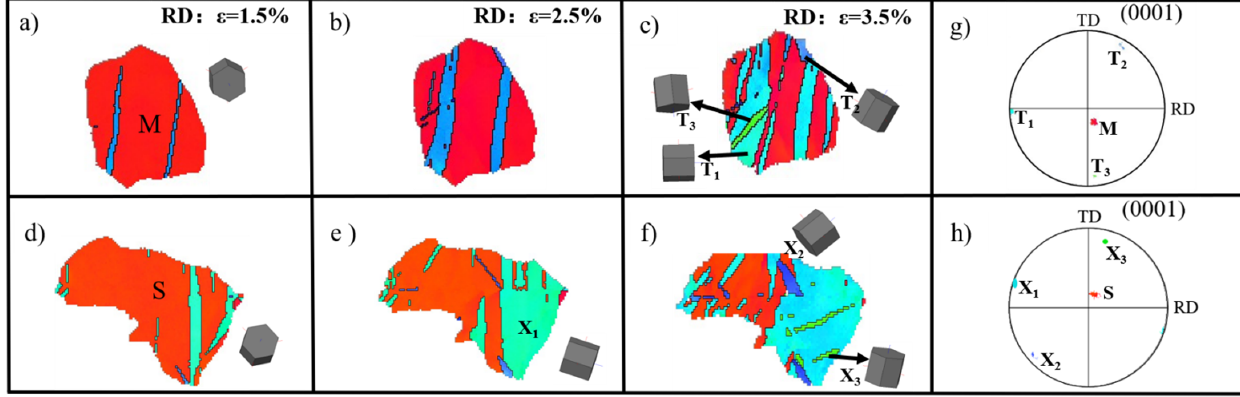
Figure 6. ( a – f ) In situ EBSD maps for selected grains at different strain levels; ( g , h ) crystallographic orientation of parent grains and twin lamellae.